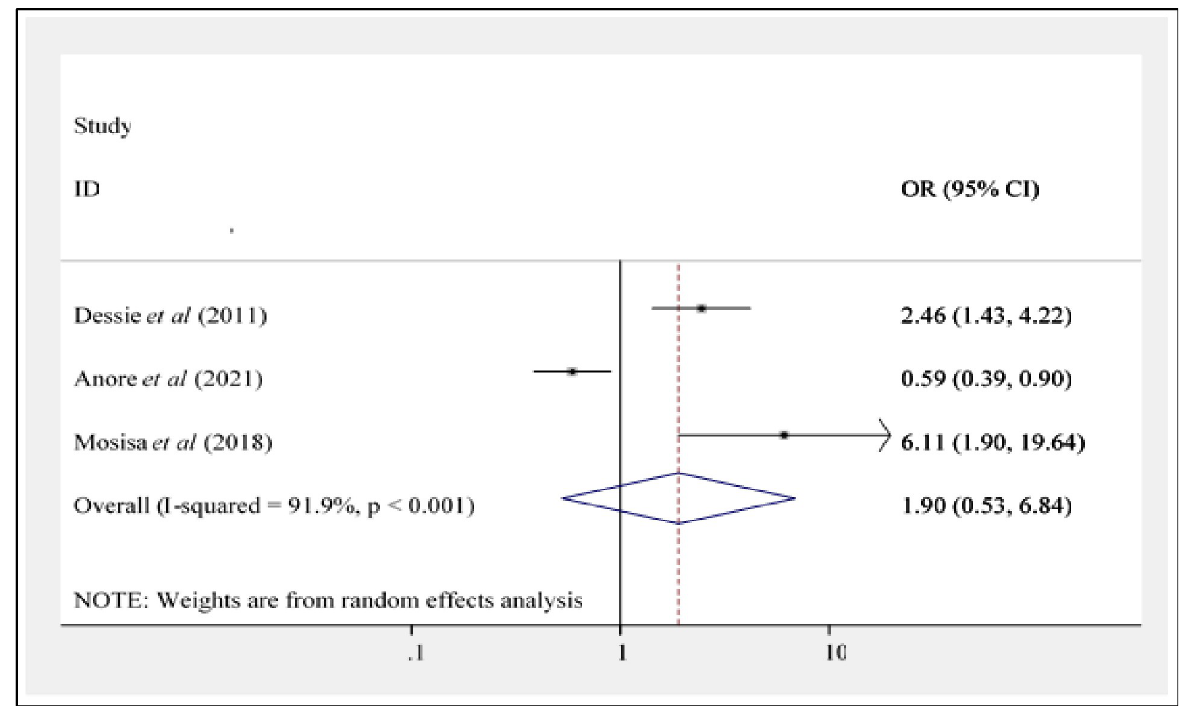
Fig 8. Forest plot showing the association between risky sexual practice and number of current partner(s) in Ethiopia.